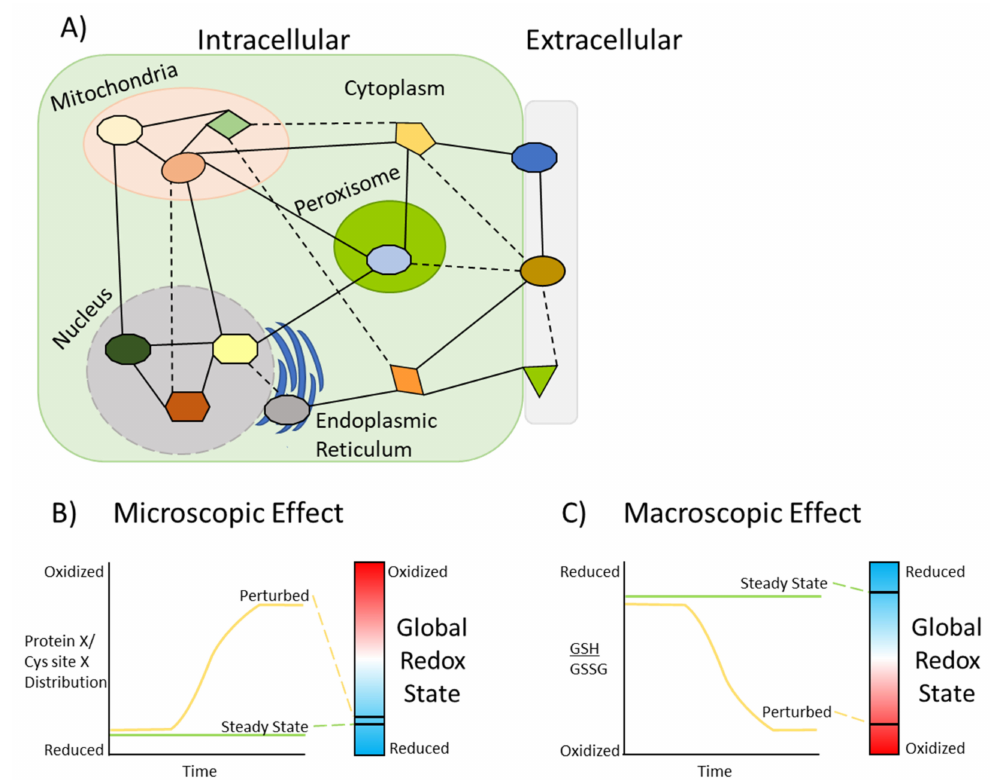
Figure 3. Modeling redox networks and redox state. ( A ) Simplified cartoon representing the redox circuits of a redox network present in the extracellular domain (e.g., receptors) and different intracellular compartments of a cell. The uniquely colored shapes represent different pathways, or circuits, that function in specific subcellular compartments. Interconnected pathways are denoted by solid lines that link the shapes, while dashed lines represent transient interactions among circuits. ( B ) Plot illustrating the microscopic effect of thiol redox signaling on the global redox state. For a given protein (protein X) or redox-sensitive cysteine site (Cys site X), the distribution of oxoforms can vary between steady state and perturbed conditions. This plot shows that the majority of oxoforms of a protein or cysteine site are reduced under steady state conditions; however, in the presence of a perturbing agent, the distribution transitions to a majority of oxidized oxoforms. As noted by the heatmap to the right, the transition of the protein or Cys site to become more oxidized following a perturbation has a negligible effect on the overall redox state of the cell. Under homeostatic conditions, the transition of reversibly oxidized proteins and Cys sites to become more or less oxidized within a specific circuit may also have little impact on the global redox state. ( C ) Plot illustrating the macroscopic effects of thiol redox signaling. In this scenario, the ratio of reduced versus oxidized glutathione (GSH/GSSG) is monitored as a readout for the global redox state. Under steady state conditions, the global redox state is under a more reduced environment (more GSH than GSSG); however, a severe perturbation causes the global redox state to become more oxidized (more GSSG than GSH). This scenario demonstrates an oxidative stress; however, the same effect could be observed from a perturbation that causes reductive stress. In the context of the model in ( A ), a macroscopic effect may be observed across multiple circuits, as opposed to a microscopic effect observed in one